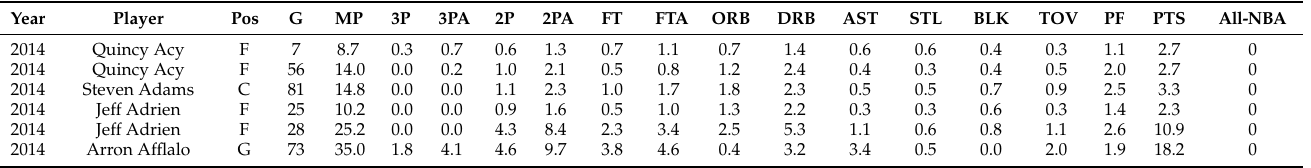
Table 1. First six rows of the dataset of all active players in the NBA seasons from 2014 to